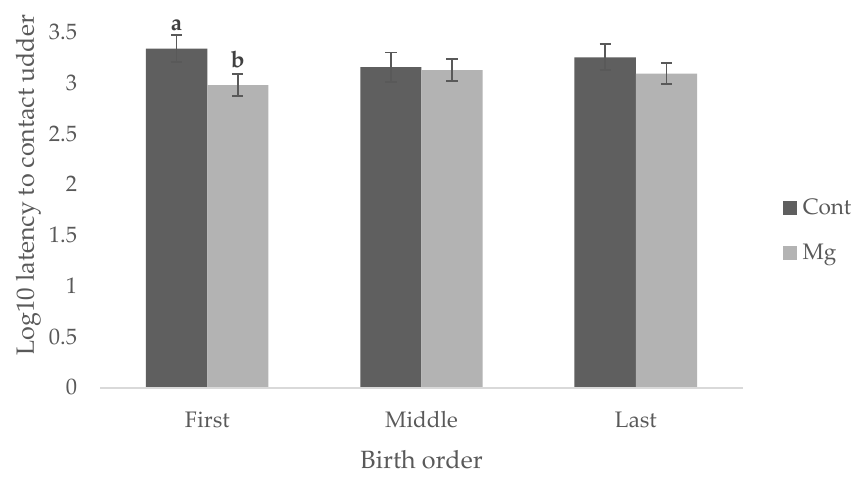
Figure 2. Mean ± s.e.m log 10 latency (in minutes) to contact the sow’s udder for piglets first (1–4), middle (5–8), or last (>8) in the birth order from sows fed a standard lactation diet (Cont) and those supplemented with 21 g/day MgSO 4 (Mg) prior to farrowing. a,b Means within birth order not having the same superscript are significantly different ( p < 0.05).